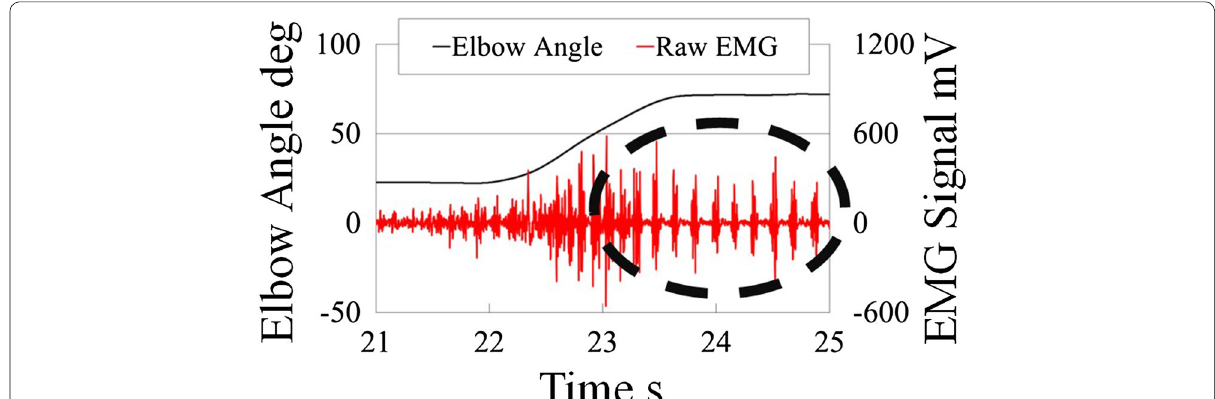
Fig. 2 Features of the EMG signals of essential tremor patients. These signals were measured from biceps brachii of real essential tremor patients when they performed elbow flexion. The red line shows the EMG signal and the black line shows the elbow